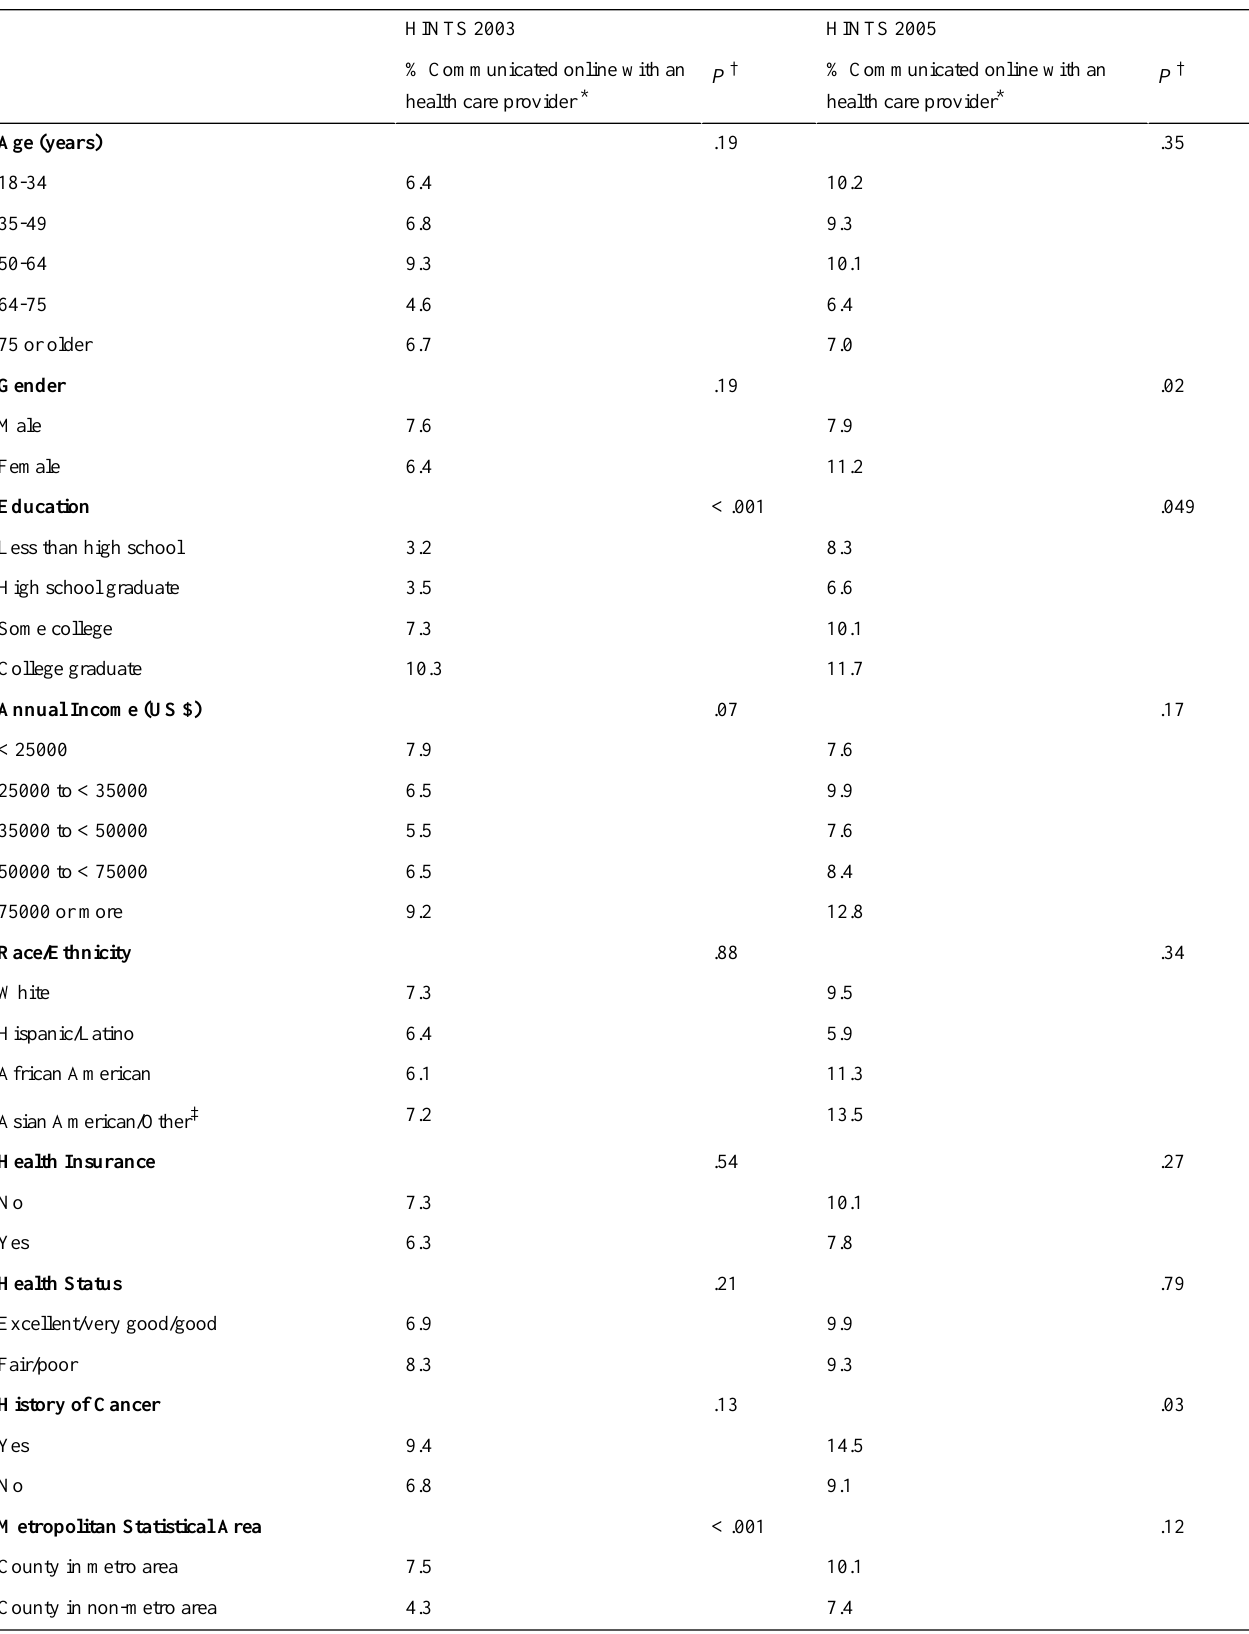
Table 2. Bivariate associations between communicating online with health care providers and study variables in HINTS 2003 and HINTS 2005